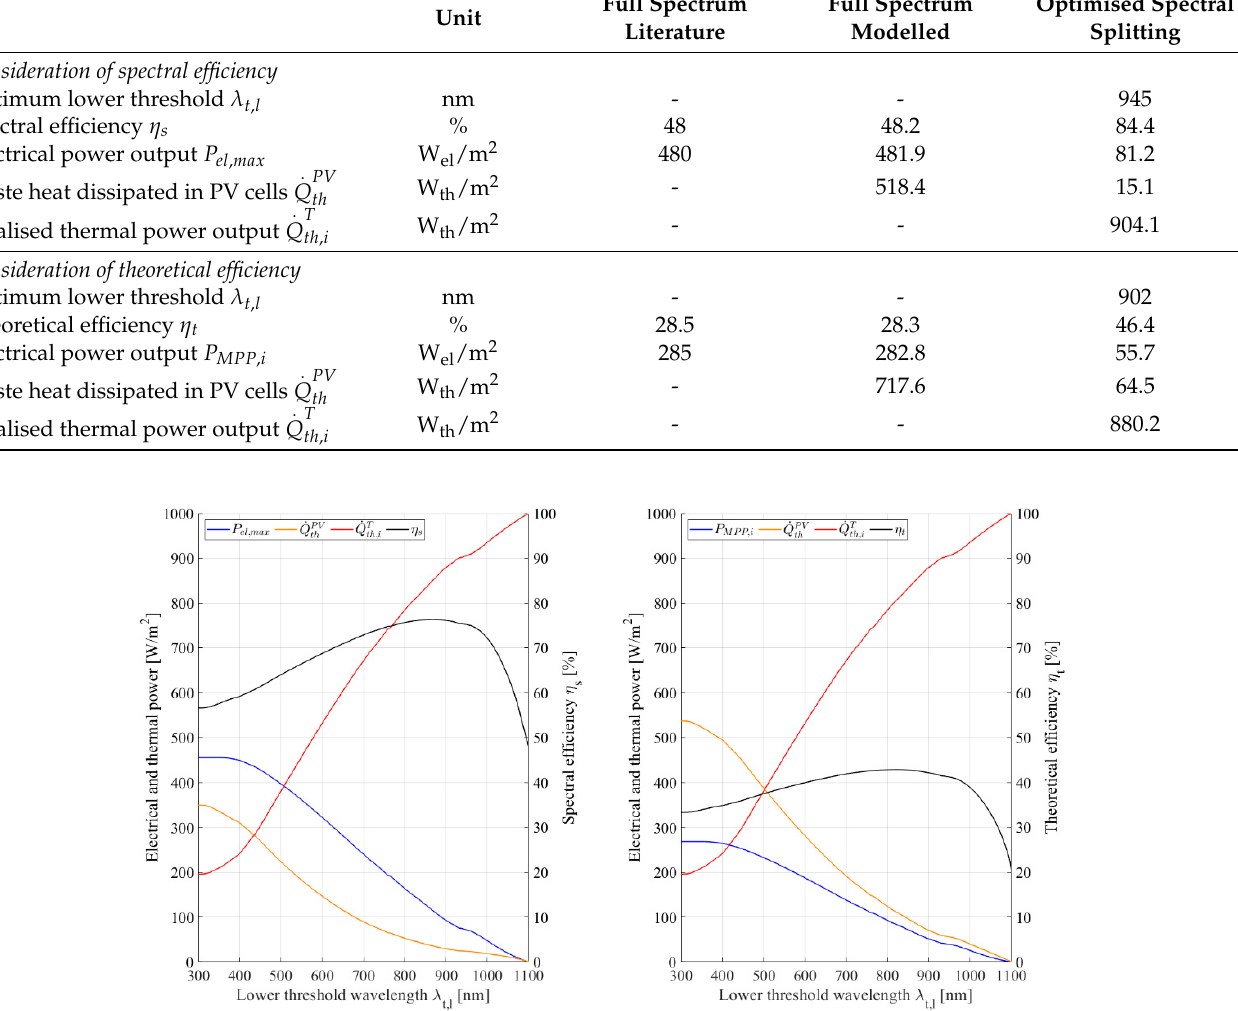
Figure 6. Key parameters of Spectral Splitting depending on lower threshold wavelength, considering spectral efficiency ( left ) and theoretical efficiency ( right ), for CIGS PV technology. Table 2. Comparison of key parameters at full spectrum and at optimum Spectral Splitting configuration for CIGS PV